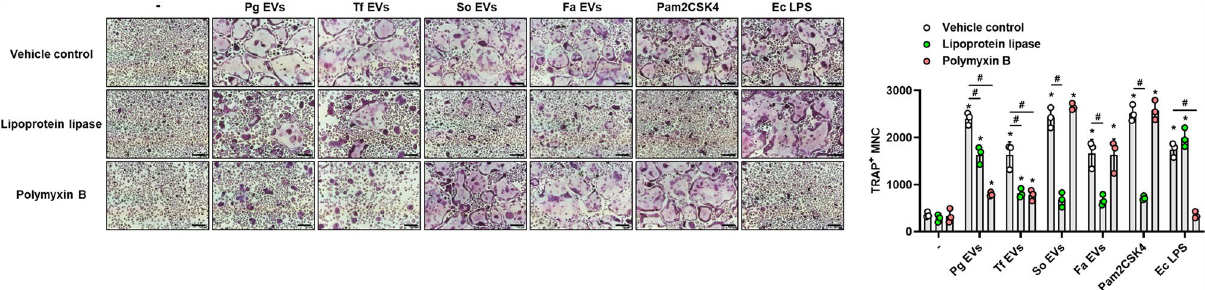
Figure 4. Role of lipoproteins and LPS in oral bacterial EVs in osteoclast differentiation. Oral bacterial EVs were incubated with 50 μg/ml lipoprotein lipase or polymyxin B at 37°C for 16 h. Then, osteoclast precursors were stimulated with oral bacterial EVs (10 μg/ml EV protein) for 3 days. For the negative control, lipoprotein lipase or polymyxin B without bacterial EVs was administered to the nontreatment group ( −). The number of TRAP + mature osteoclasts was counted (right panel). The experiments were performed at least three times independently. Pam2CSK4 (1 μg/ml) and E. coli LPS (1 μg/ml) were used as positive controls. The graphs show the mean values ± standard deviations of a representative experiment. Statistical significance was determined by two-way ANOVA. * P < 0.05 compared with the nontreatment group ( −). # P < 0.05 compared with the indicated (Fig. 3C). Lr EVs did not activate TLR2, TLR4 or TLR9 in our experimental conditions. To identify the role of TLR2 in bacterial EV-induced osteoclast differentiation, WT or TLR2 −/− osteoclast precursors were stimulated with bacterial EVs without RANKL. Pg EVs and Tf EVs slightly induced osteoclast differentiation in TLR2 −/− osteoclast precursors, but So EVs and Fa EVs did not induce it at all (Fig. 3D). Lr EVs did not induce osteoclast differentiation in either WT or TLR2 −/− osteoclast precursors. Likewise, ELISA data showed that major osteo- clastogenic cytokines (TNF-α, IL-6 and IL-1β) were increased in WT osteoclast precursors by Pg EVs, Tf EVs, So EVs, and Fa EVs (Fig. 3E). However, in TLR2 −/− osteoclast precursors, osteoclastogenic cytokines were not induced by all EVs. These results suggest that TLR2 may be the major immune receptor for the recognition of oral bacterial EVs, leading to osteoclast differentiation and activation. Effects of lipoproteins and LPS from oral bacterial EVs on osteoclast differentiation. Bacterial lipoproteins and LPS are known as major TLR2 and TLR4 ligands of bacterial EVs, respectively 11,12 . Recently,